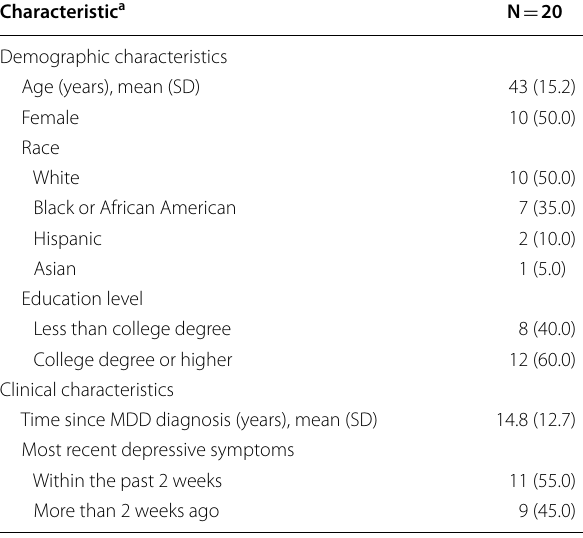
Table 1 Patient characteristics at